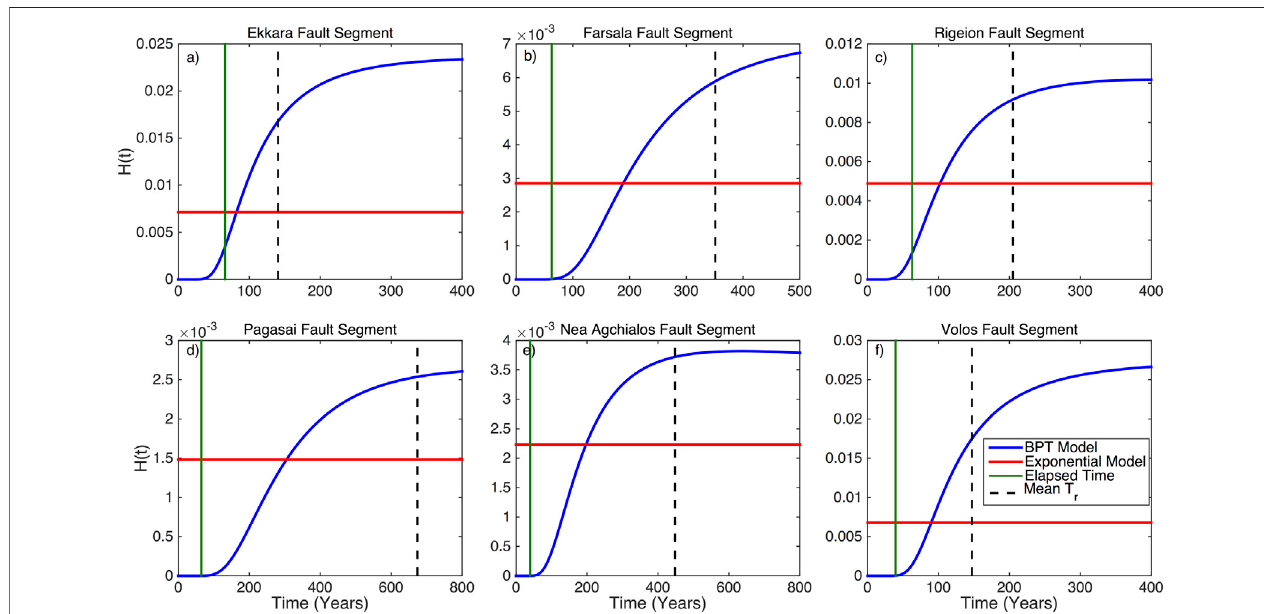
FIGURE10| Hazardfunctions, h ( t ),fortheEkkara (A) ,Farsala (B) ,Rigeion (C) ,Pagasai (D) ,NeaAgchialos (E) ,andVolos (F) FaultSEgmentsaccordingtotheBPT renewal model (blue lines) against the memoryless exponential (red lines) one. Green lines represent the elapsed time since the last earthquake ( t (cid:1) 0), while the dashed black lines the mean T r of the M w ≥ 6.0 as obtained from the statistical analysis of the simulated catalog ( Table 5 ) for each one of the six segments.